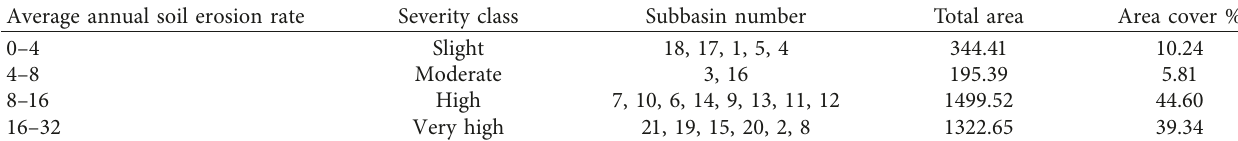
Table 7: Ketar subbasins and their soil erosion rates.